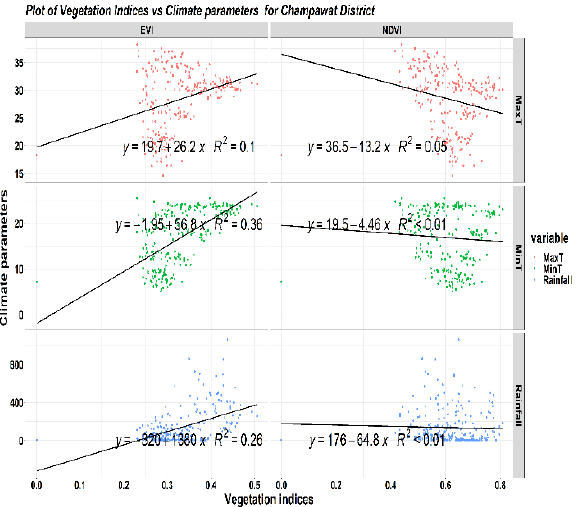
Figure 13. Scatter Plot between Vegetation Indices and Climate Parameters for Champawat